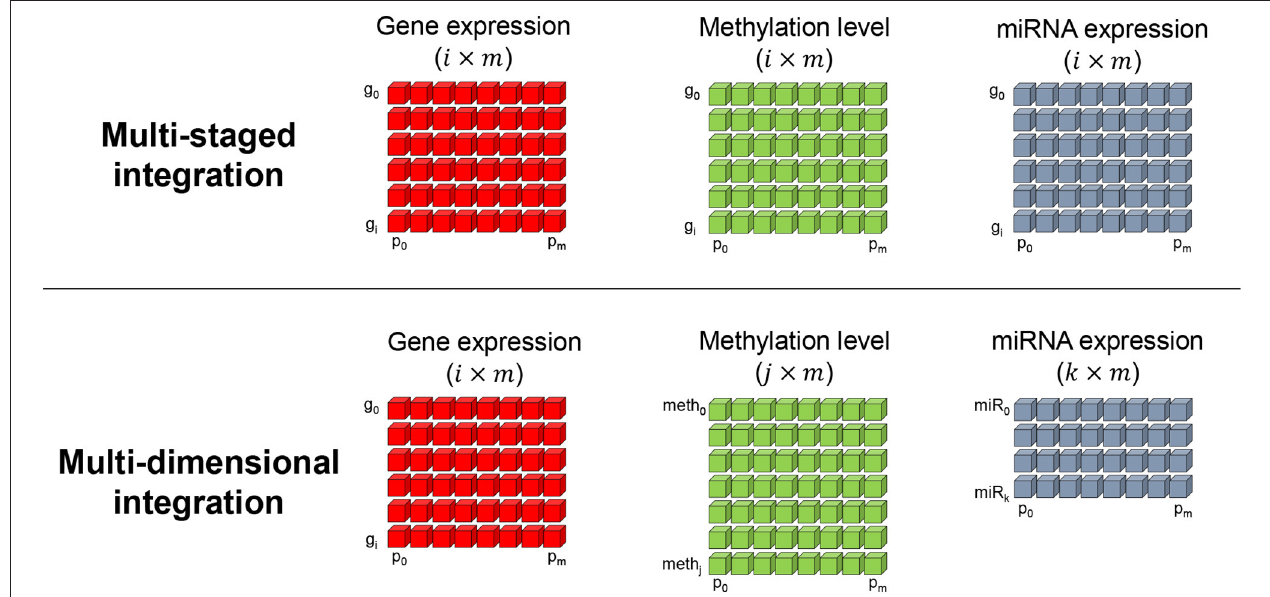
FIGURE 2 | Two prevalently used multi-omics integration methods. The multi-staged (top) , or gene-centric, method encodes all omics measurement values in a per gene basis. Hence, the number of genes ( g ) and samples (or patients p ) in each omics matrix are required to have equal dimensions. The multi-dimensional (bottom) integration method is less restrictive in the dimensions and makes use of each omics data as